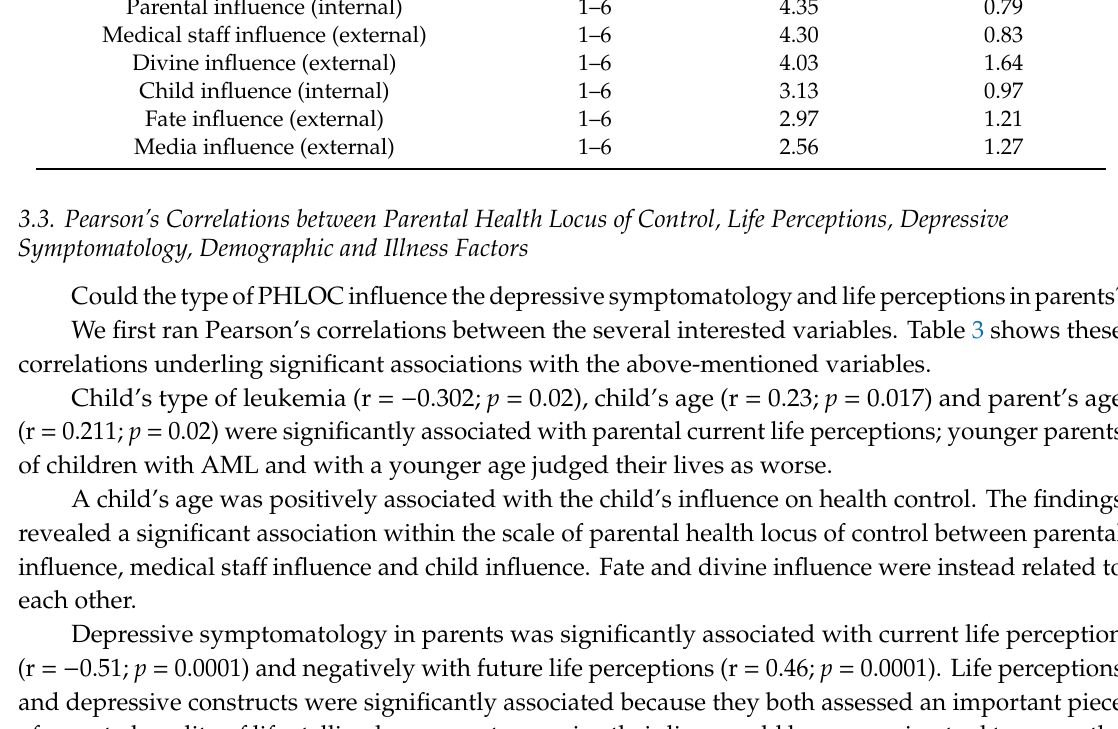
Table 2. Descriptive statistics of parental locus of control styles on child’s illness. Locus of Control Styles